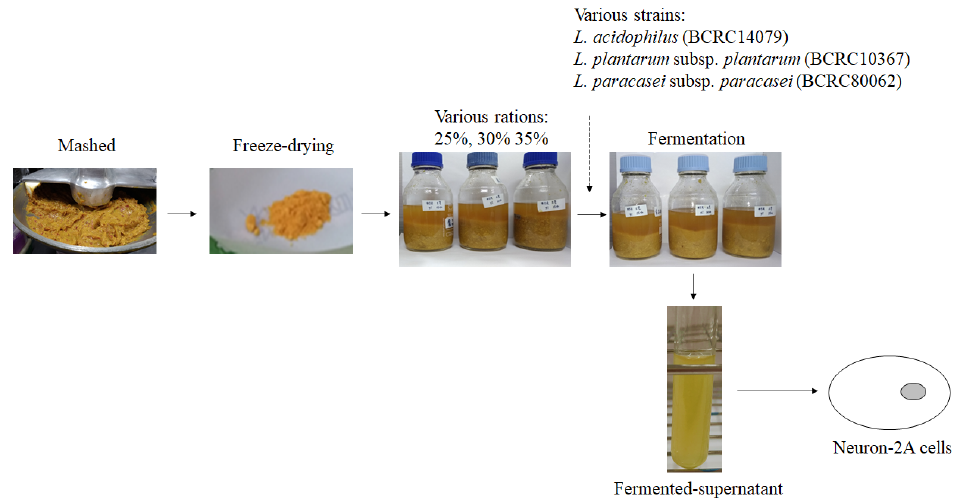
Figure 1. The fermented-process of mango peel by L. acidophilus (BCRC14079), L. plantarum subsp. plantarum (BCRC10367), and L. paracasei subsup. paracasei (BCRC80062). Table 1. The changes of pH and titratable acidity in fermented-mango peel (30%) by various lactic acid bacteria over the fermentation period.